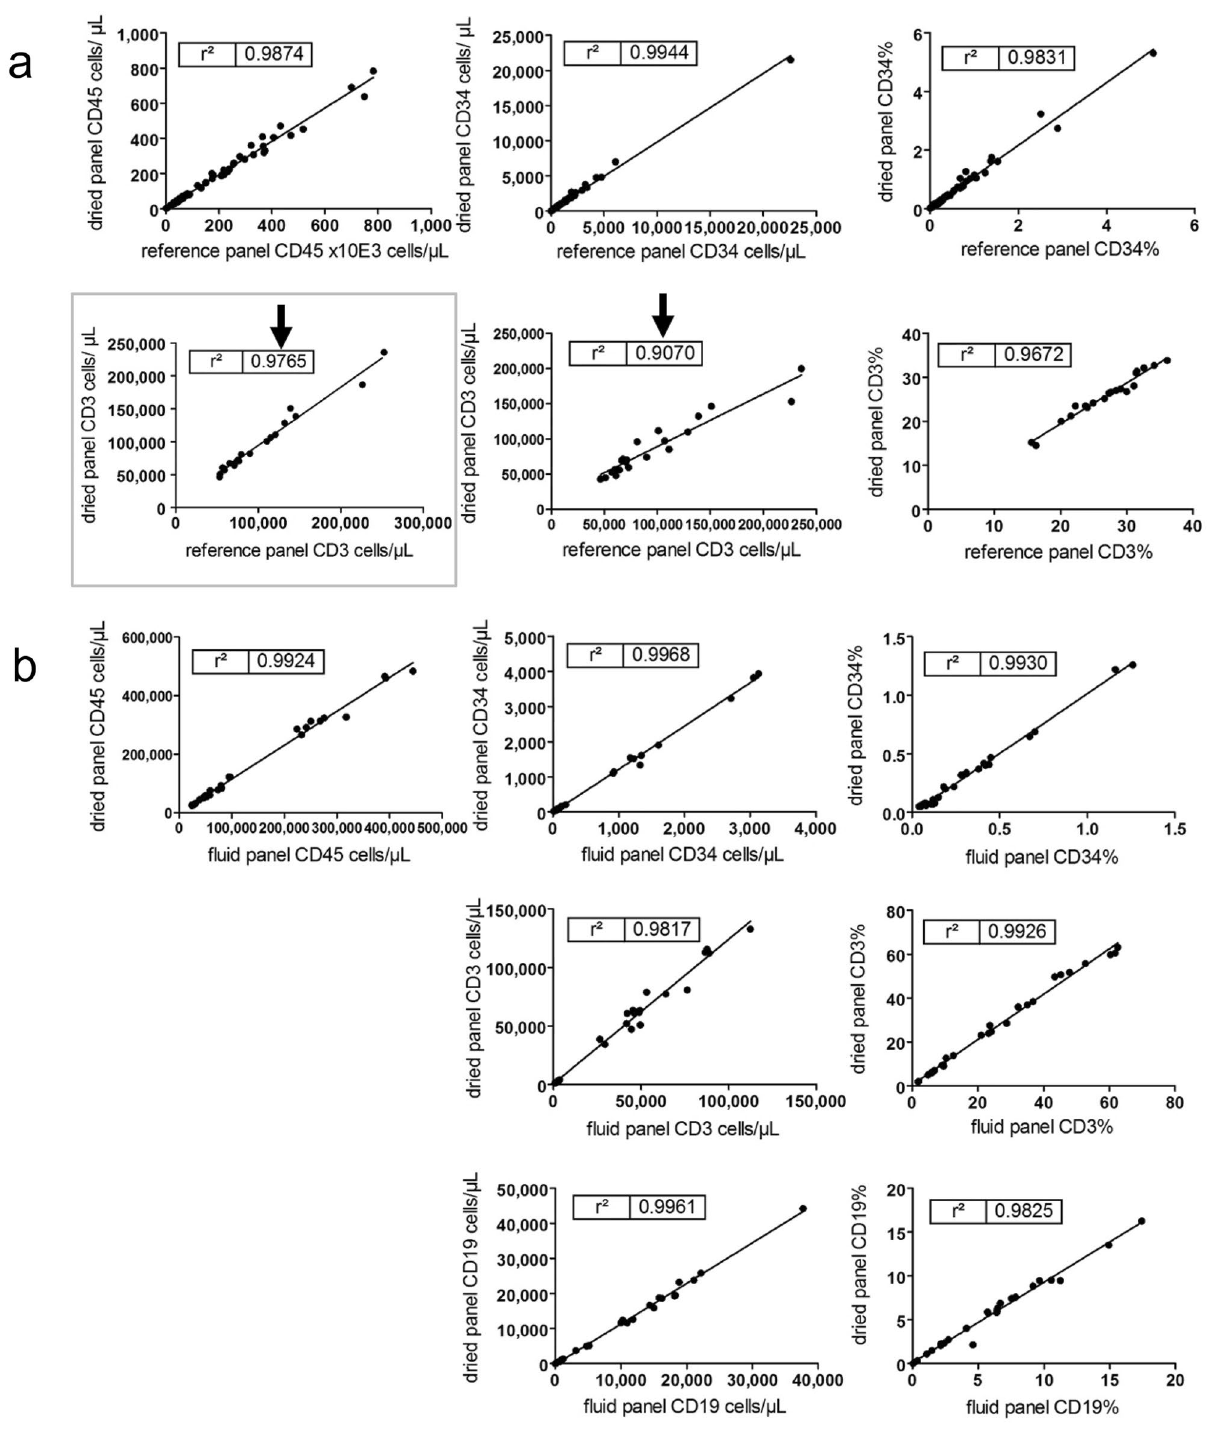
Figure 2. Validation results for accuracy testing. ( a ) Comparison the counting results of stem cells and T cells between the pre-formulated dried reagent panel including CD45 FITC, CD34 PE, 7-AAD, CD3 PB and CD19 APC and counting beads as well as the reference method using separated CD34 and CD3 determinations and the fluidic antibodies CD45 FITC, CD34 PE and CD45 FITC, CD3 PE each with 7-AAD and true count beads (autologous specimens only CD34 enumeration). Standard allogenic and autologous stem cell apheresis (n = 33) and mobilized whole blood (n = 35) of donors and patient after mobilization were compared by linear regression regarding the results of absolute counts in cells/µL (CD45 × 10 3 , CD34, CD3) and frequencies in % (CD34, CD3). ( b ) Accuracy of the measurement of the pre-formulated dried reagent panel and similar fluidic reagent panel (CD45 FITC, CD34 PE, 7-AAD, CD3 PB, CD19 APC and counting beads) were compared as described under ( a ) (LA of all cohorts: n = 17), whole blood of mobilized donors and patient (n = 11) including stem cells, T and B